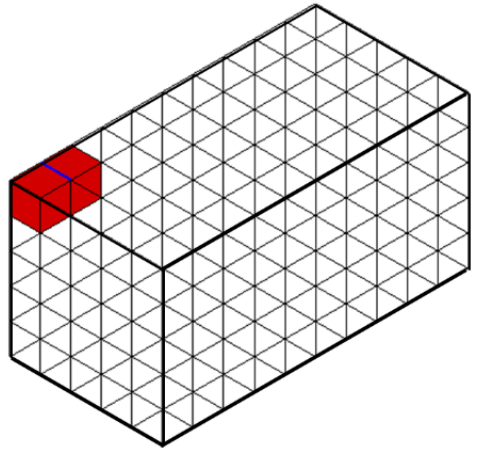
Figure 7. An example of incidence queries (red) for a non-manifold vertex (blue).